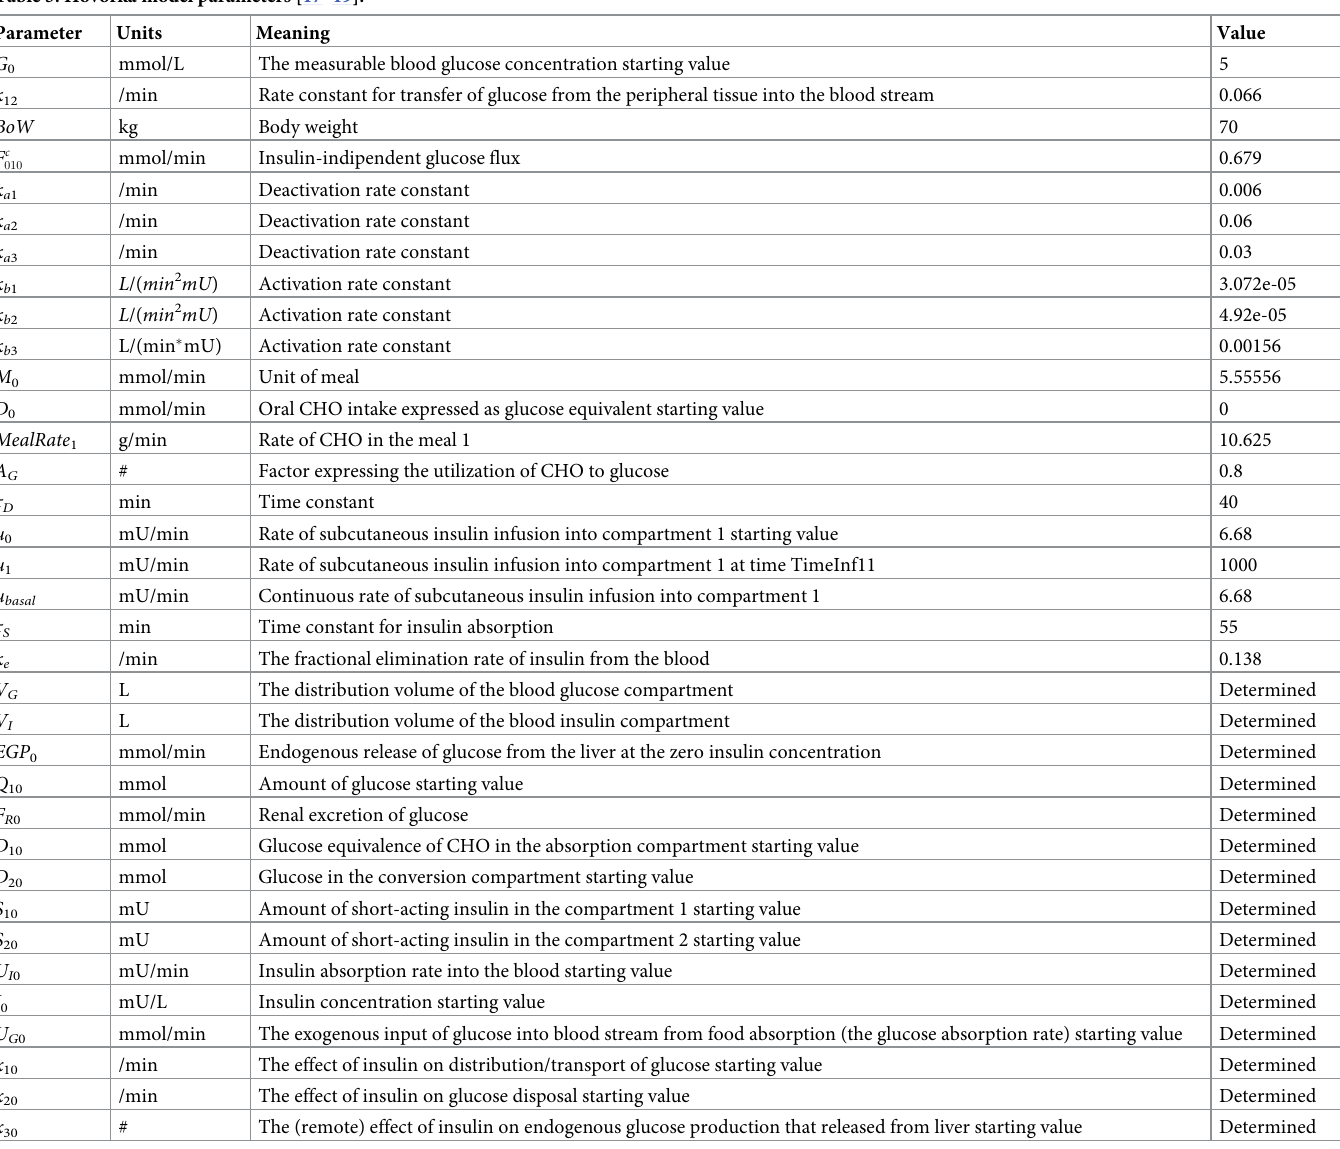
Table 3. Hovorka model parameters